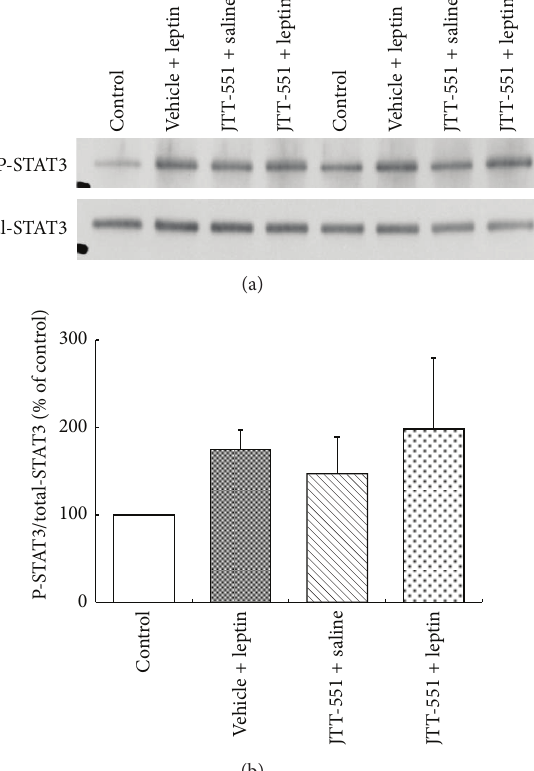
Figure 2: Enhancement effects of JTT-551 on STAT3 phosphoryla- tion in the hypothalamus of DIO mice. The detected bands (typical bands) are shown in (a) and the phosphorylation-STAT3/STAT3 in each group in (b). The intensity of the STAT3 phosphorylation was calculated as the ratio of the density of phosphorylation-STAT3 to the density of